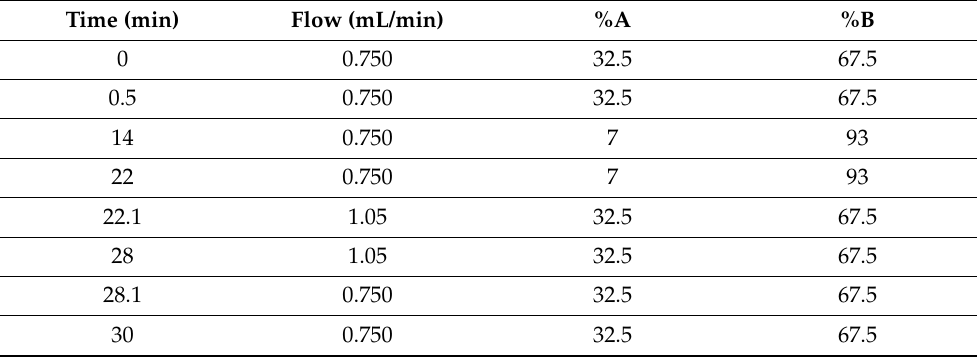
Table 8. Gradient elution of HPLC–UV-MS.